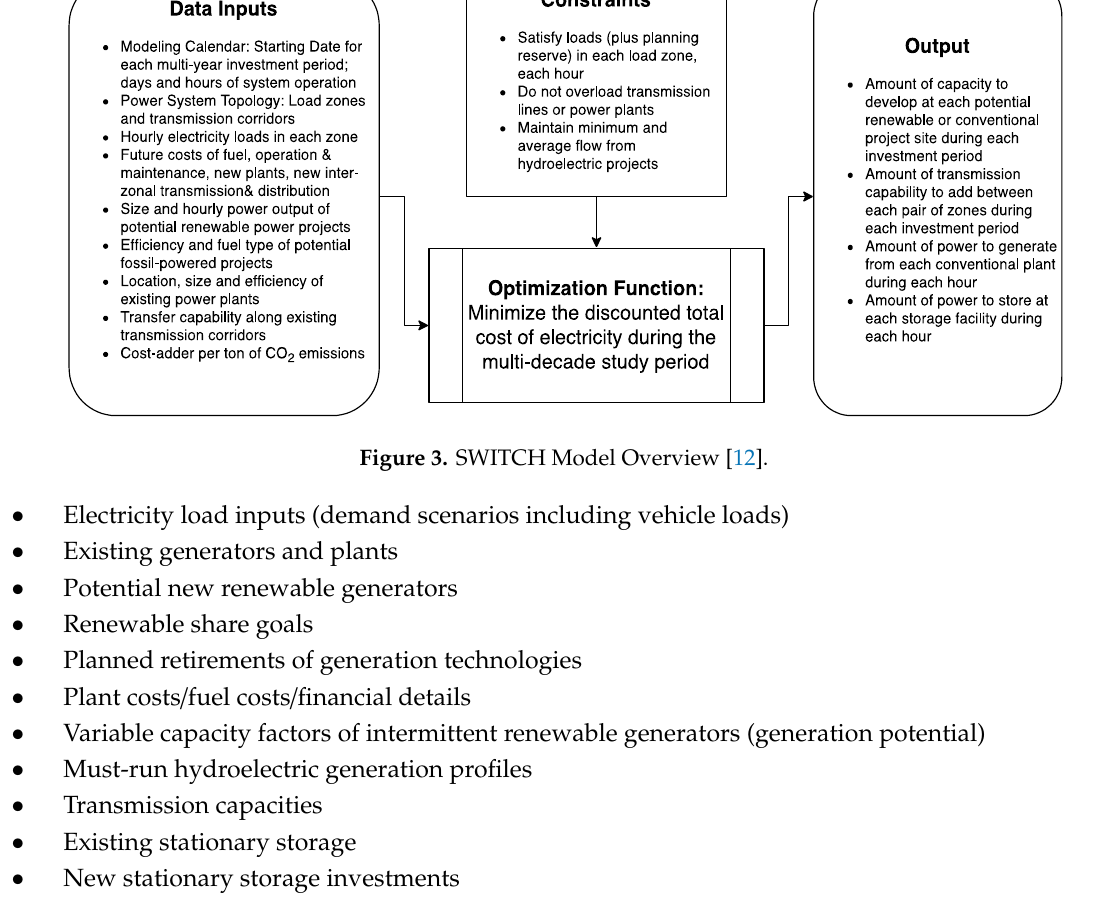
Table 12. Cost Factors for New Renewable Generators.